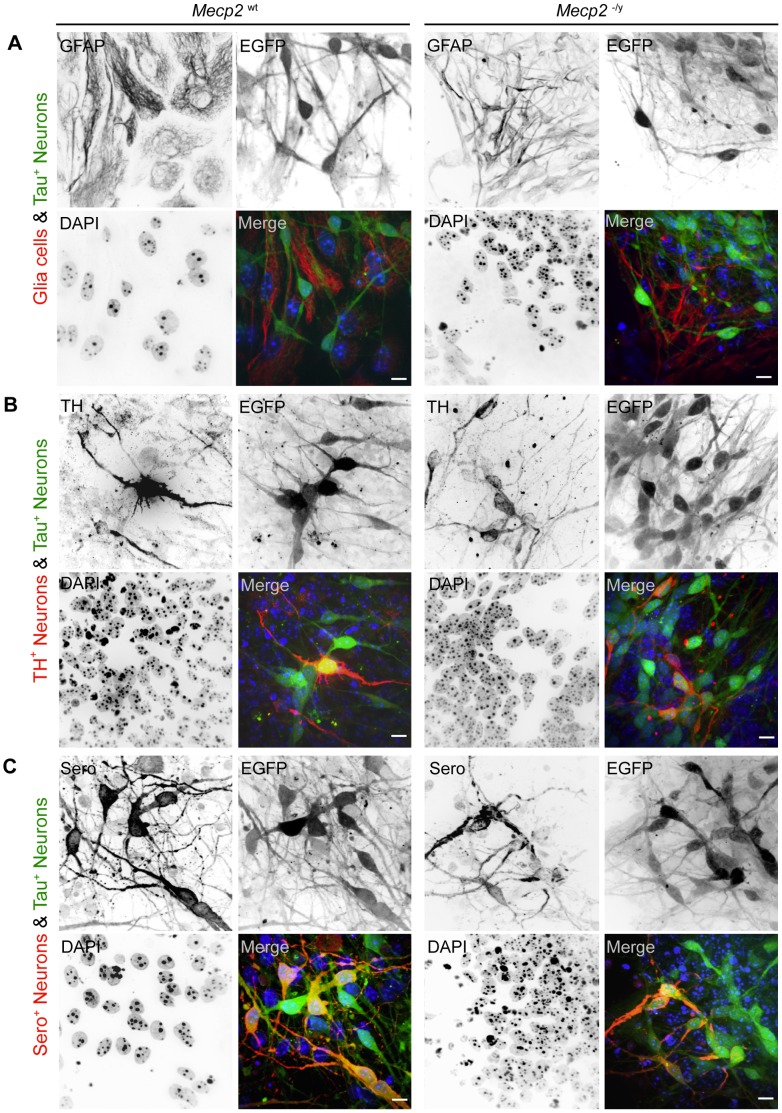
MeCP2 absence does not prevent neuronal and astroglia differentiation.Confocal microscopy optical sections of Mecp2 wild type (left) and Mecp2 deficient cells (right) at differentiation day 13 revealed astroglia (GFAP+) and different neuronal subtypes (EGFP+, TH+, Sero+). Bar: 10 µm. A. Differentiated Mecp2 wild type and Mecp2 deficient cells exhibit GFAP positive astroglia (red) and EGFP positive neurons (green). Both labels marked mutually exclusive cell populations. B. The population of EGFP positive cells could be further subdivided into tyrosine hydroxylase (TH+) positive neurons (red). Those cells were found to be present in both Mecp2 wild type and Mecp2 deficient cells. While not all EGFP+ neurons (green) are TH+, all TH+ are positive for EGFP (yellow color in overlay). C. In addition to a TH+/EGFP+ subpopulation neurons, another serotonin positive (Sero+) subpopulation was detected in both cell lines. Similar to the situation described above, Sero+ cells (red) were always EGFP+ (green) while a considerable amount of EGFP+ cells were Sero−.